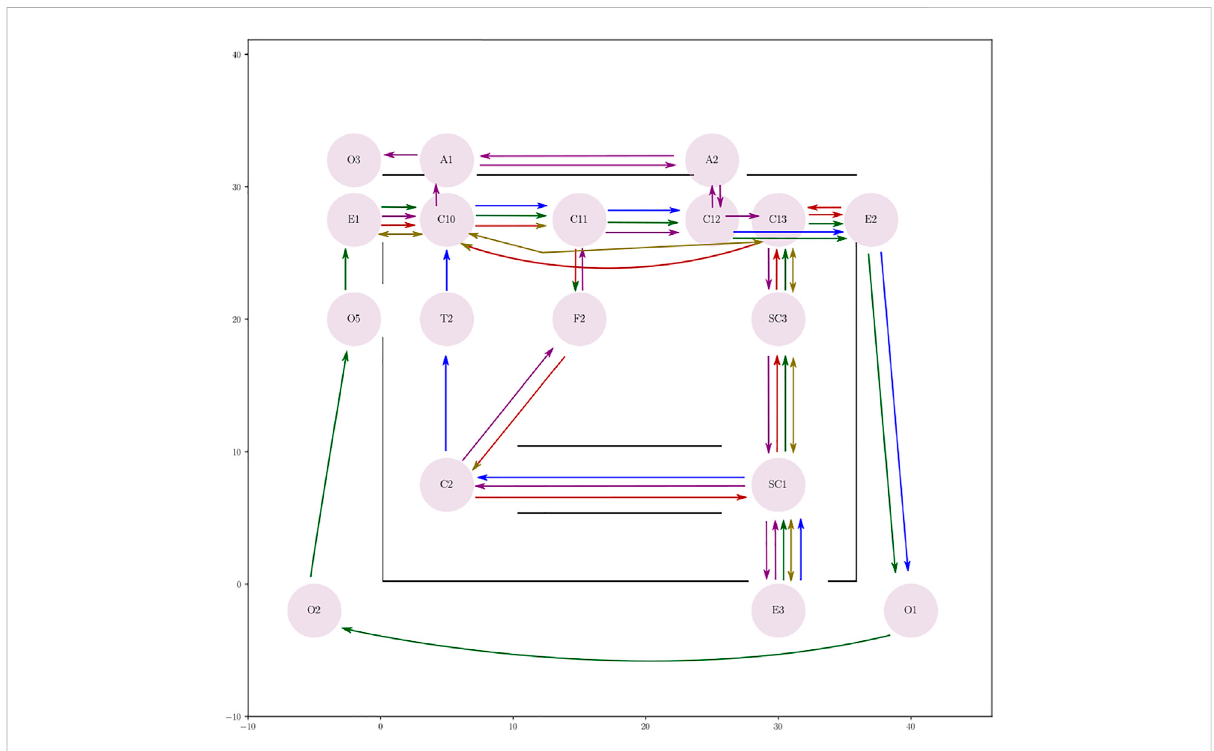
FIGURE 4 Set of waypoints and paths used to simulate workers in a warehouse-like environment using the PedSim simulator. Different colored arrows show the paths taken by different groups of pedestrians. Circles in light pink show the way